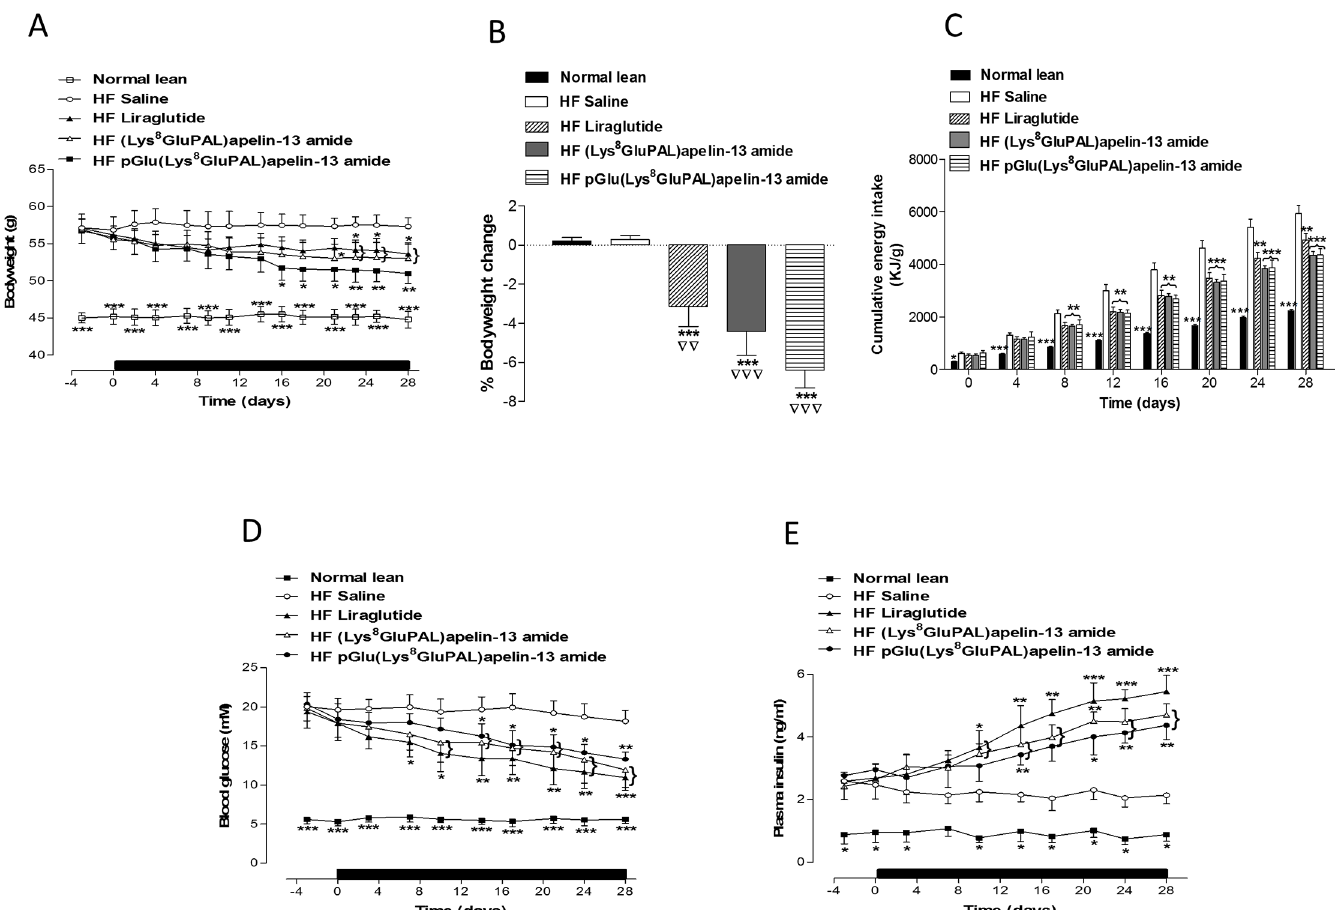
Fig 1. Chronic effect of once daily i.p. administration of liraglutide, (Lys 8 GluPAL)apelin-13 amide or pGlu(Lys 8 GluPAL)apelin-13 amide (each at 25 nmol/kg bw) for 28 days on body weight (A), % weight change (B), cumulative energy intake (C), non fasting blood glucose (D) and plasma insulin (E). Treatment period represented by black horizontal bar. Values represent mean ± S.E.M. (n = 8) where (cid:3) p < 0.05, (cid:3)(cid:3) p < 0.01 and (cid:3)(cid:3)(cid:3) P < 0.001 is compared to high-fat fed saline treated mice, 55 p < 0.01 and 555 p < 0.001 is compared to lean mice fed on a normal diet.